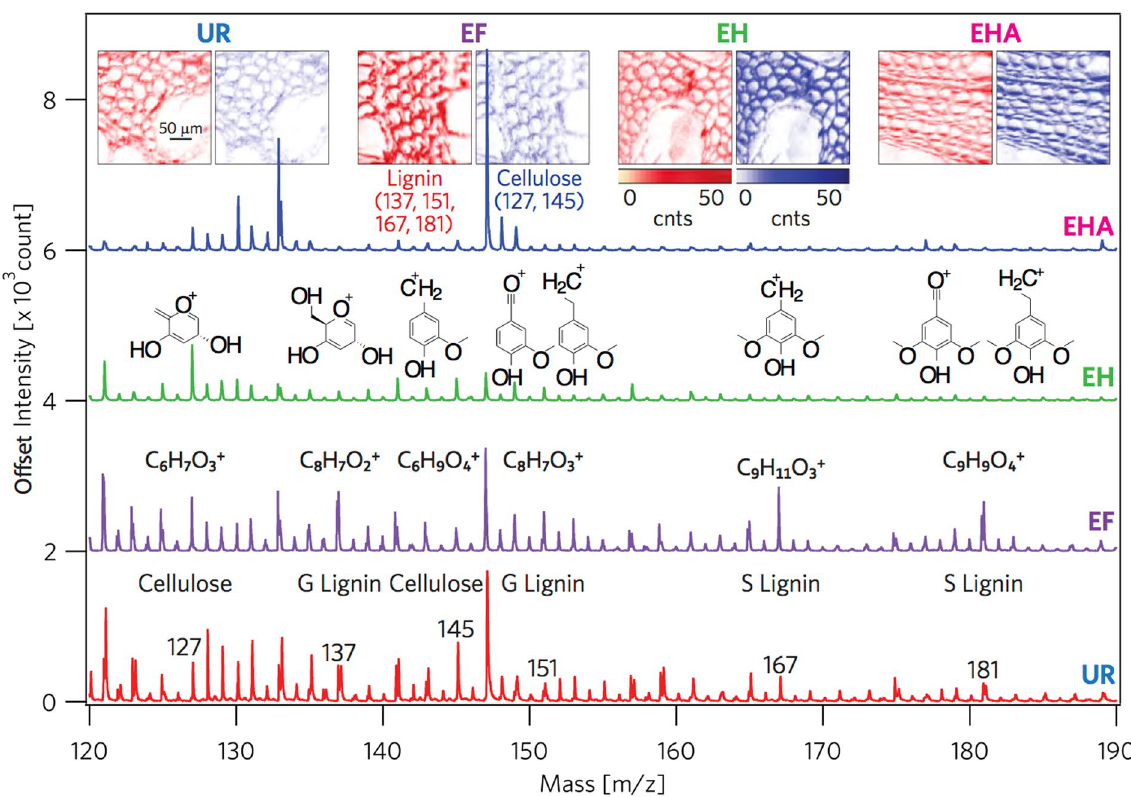
Figure 2. Tracing delignification by identifying cellulose, G lignin, and S lignin ion currents. The cellulose ( m / z = 127 and 145) and lignin ( m / z = 137, 151,167, 181) intensities of secondary ion mass spectra (offset separated) are displayed with their molecular structures. The image insets show the spatial mapping of the sum of the lignin and cellulose components for each processing step. See the supplementary materials for details and the m / z assignments.